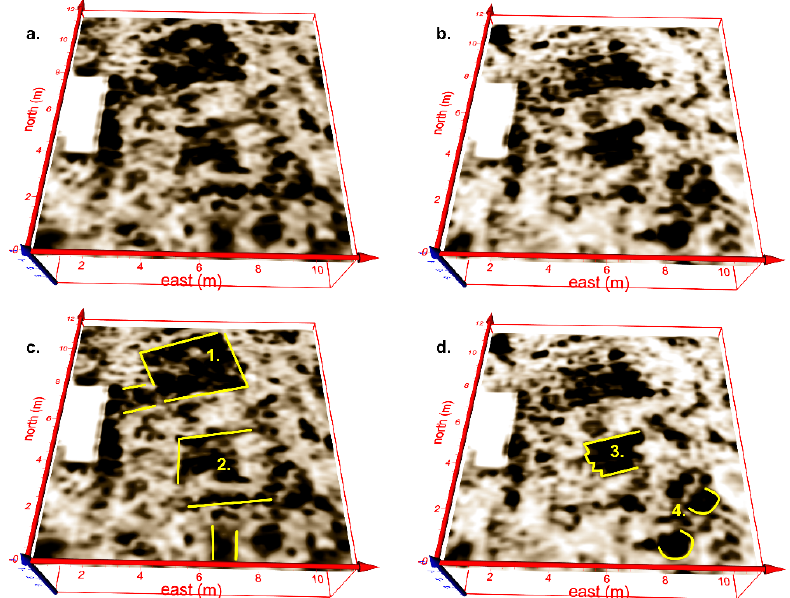
Figure 9. ( a ) Portion of a Birnirk house complex in the active layer (upper meter) with layout and dimensions consistent with nearby excavated examples. The darker colors indicate higher amplitude reflections from buried wood, bone and other material as seen in the nearby excavation; ( b ) Portion of a Birnirk house complex in the frozen layer (extending below one meter) with layout and dimensions consistent with nearby excavated examples. This is a deeper portion of the same house complex shown in ( a ); ( c ) Annotated interpretations 1 and 2 indicated the proposed outline of structures interred from ( a ), along with likely tunnel locations. The orientation and scale of these features are comparable to the nearby excavation (Figures 10 and 11), and the excavated and unexcavated structures are likely connected; ( d ) Annotations indicate a likely cluster of timbers, three, and external storage pits, four. Other discrete anomalies scattered throughout the survey area are likely caused by debris such as wood and whale bone external to the structures. This is also consistent with the nearby excavation.